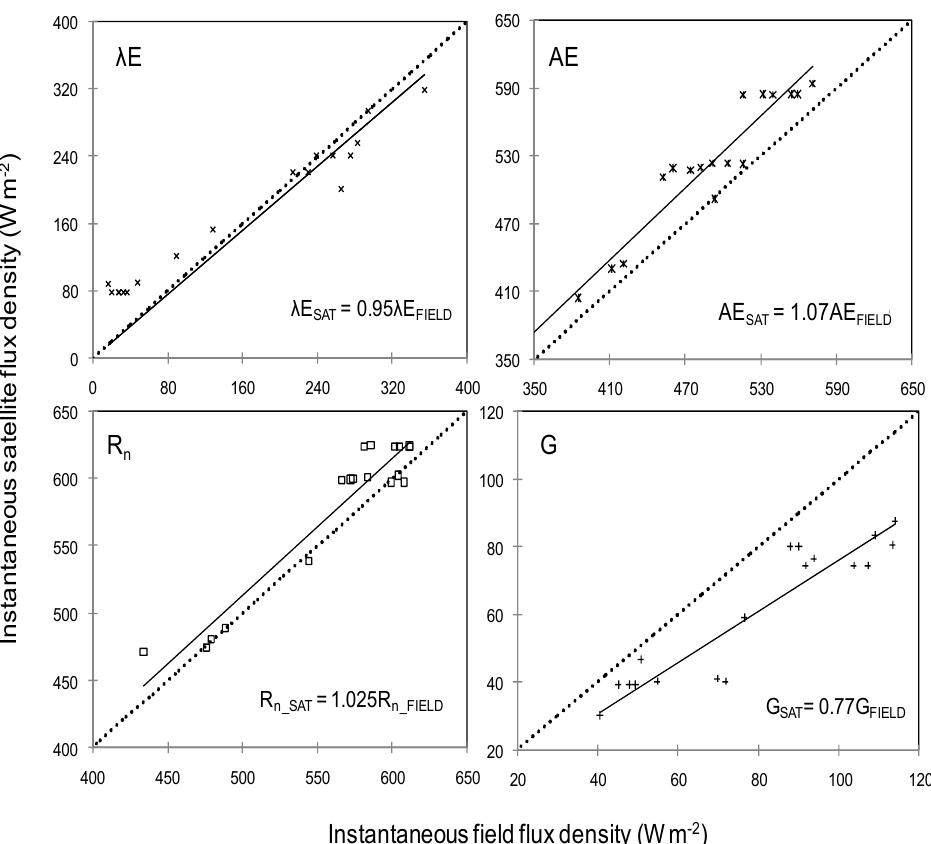
Figure 6. Relationships between instantaneous radiation and energy balance components from satellite (subscript SAT) and from field measurements (subscript FIELD): λ E—latent heat flux; AE—Available energy; R —net radiation; G—soil heat flux. n